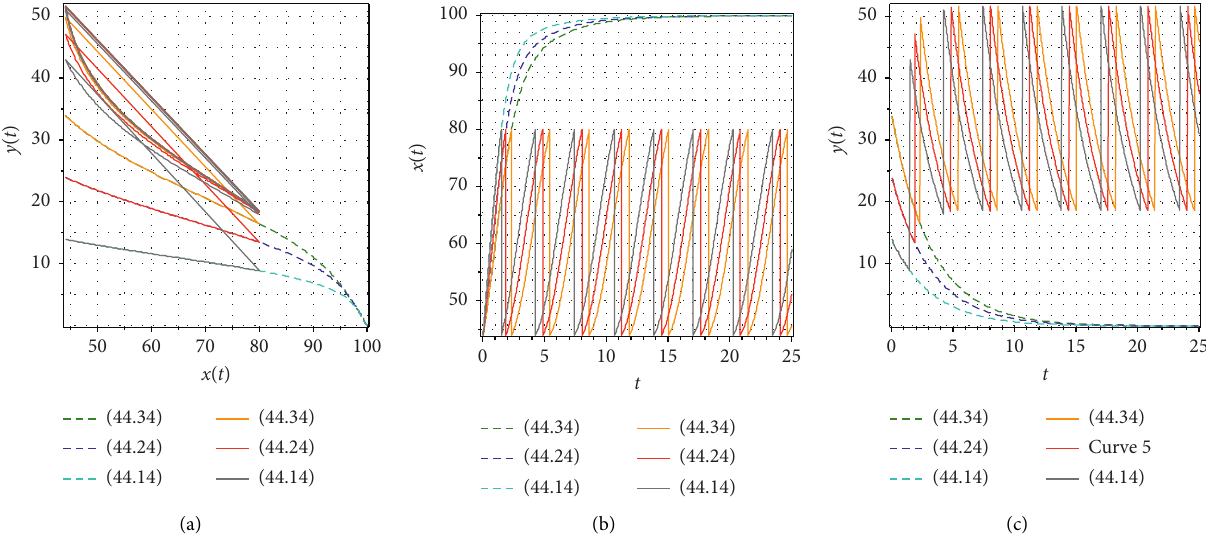
Figure 6: Numerical simulations when Φ ( y ) < y A A . (a) Phase portrait of x ( t ) and y ( t ). (b) Time series of x ( t ). (c) Time series of y ( t ). The solution of system (2) is presented in full line, and the solution of free system (1) is represented in dotted lines.